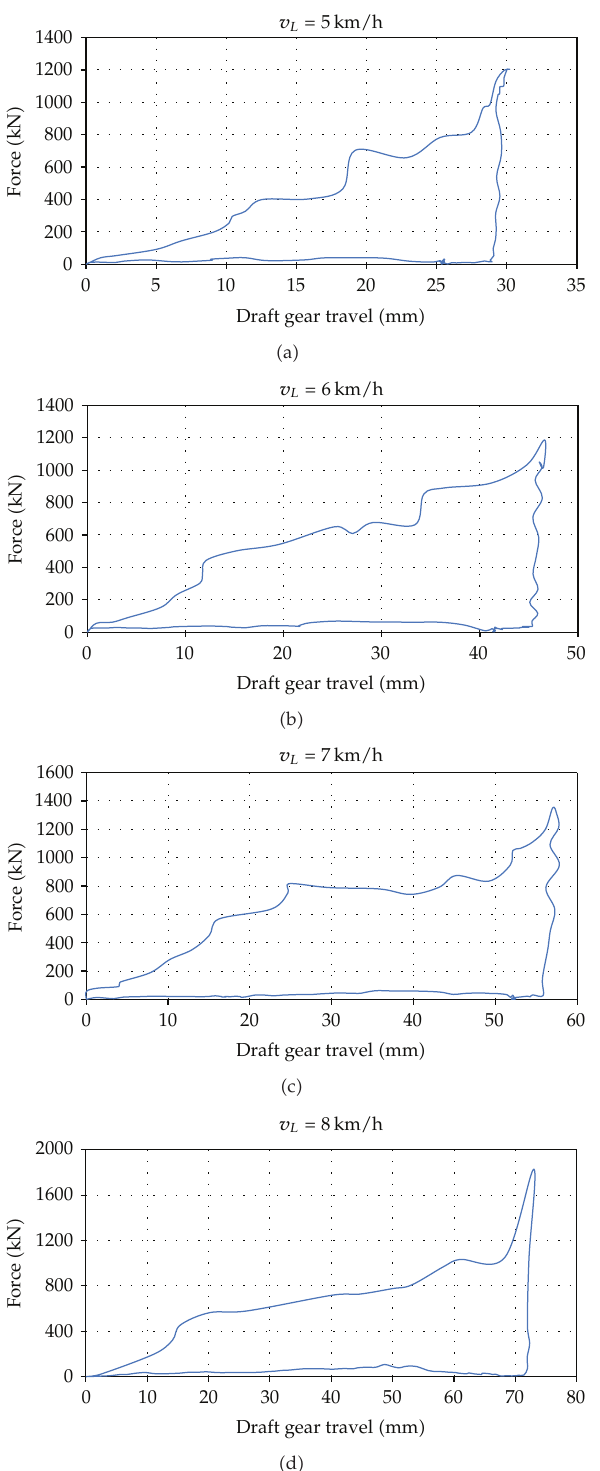
Figure 9: Draft gear force and travel characteristic curves. v L is the velocity of striking car just before